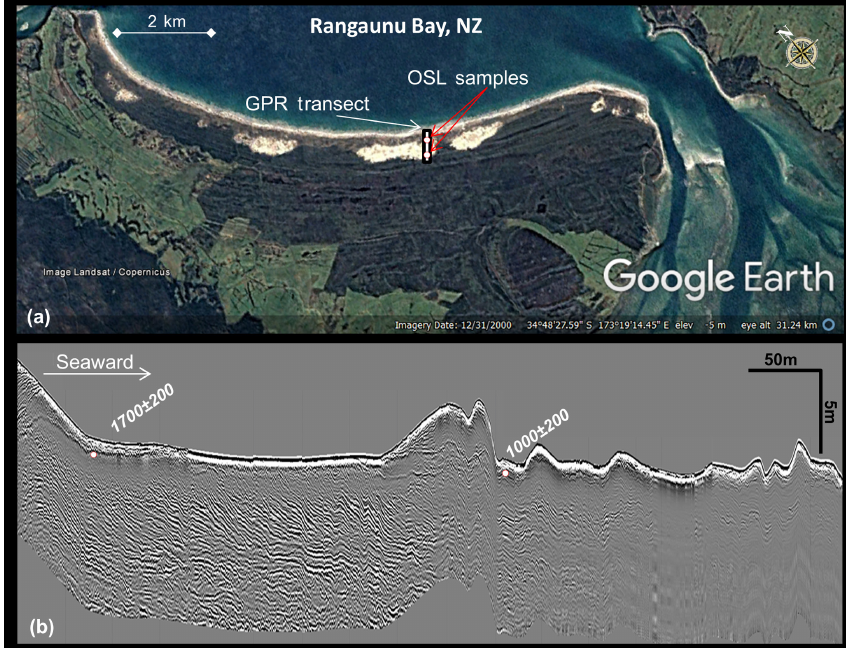
Figure 5. (a) Google Earth image of East Beach, New Zealand, and the prograded barrier that it fronts. This aerial image shows the distinct change in morphology from the older vegetated foredune ridges to a large dune blowout fronted by low-lying irregular foredunes with sparse vegetation. This information was used to guide collection of the GPR to image the stratigraphy associated with these two changes in morphology (a–b) . The GPR data revealed a major change in the stratigraphy from strong prograded beachface reflections to low-amplitude more chaotic reflections in the beachface. Both the morphology and stratigraphy were used to determine OSL ages (years before 2005) of the youngest intact relict foredune ridge ( ∼ 1 . 7ka) and the timing of the drastic shift in evolution observed in both the dune morphology and beach facies stratigraphy ( ∼ 1 . 0ka). Note that GPR is particularly useful to study nearshore dynamics in the stratigraphy at this site, since its location in the high-energy breaker zone makes this region difficult to access and monitor. Figure modified from Dougherty